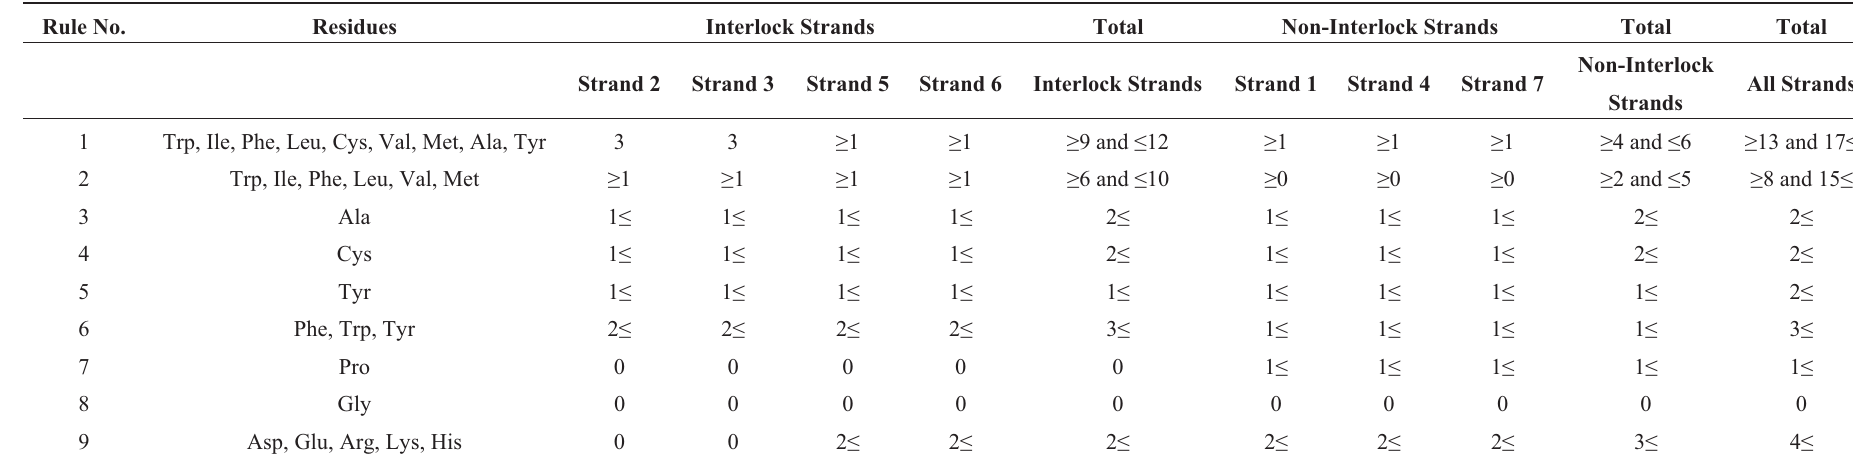
Table 1. The rules of assignment of residues at hydrophobic positions in strands.